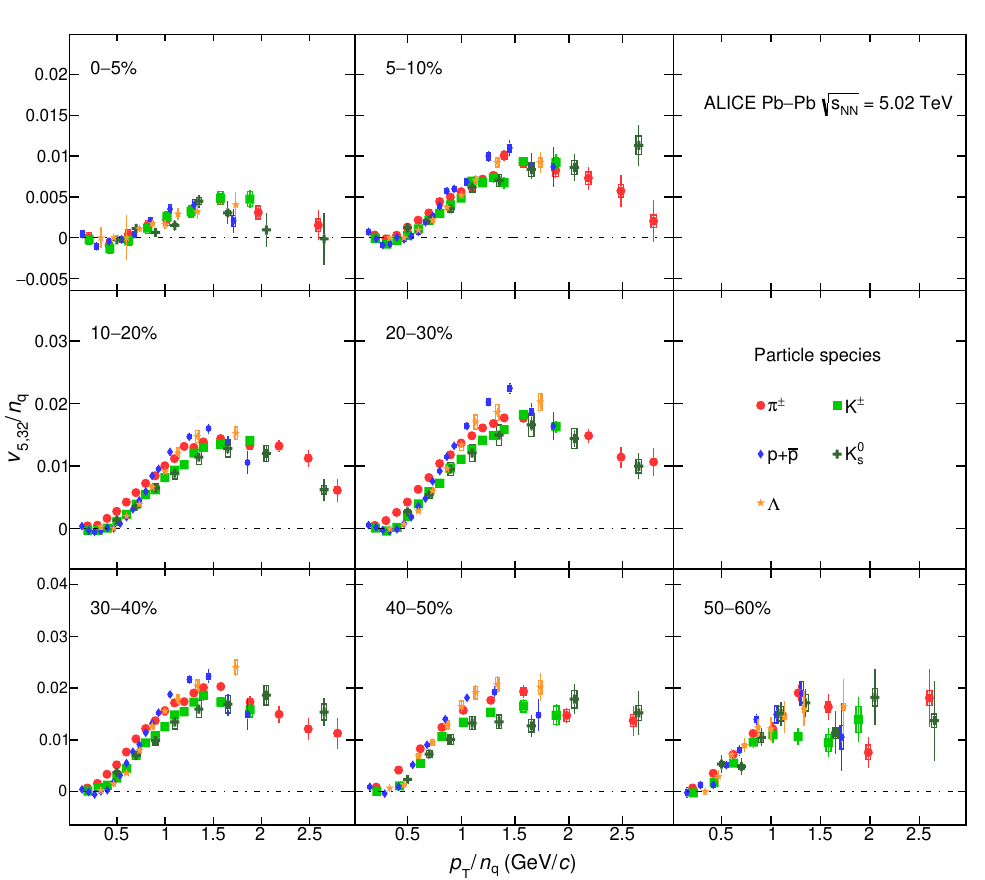
Figure 11 . The p T =n q -dependence of v 5 ; 32 =n q for di(cid:11)erent particle species grouped into di(cid:11)erent p centrality intervals of Pb-Pb collisions at s NN = 5 : 02 TeV. Statistical and systematic uncertainties are shown as bars and boxes,